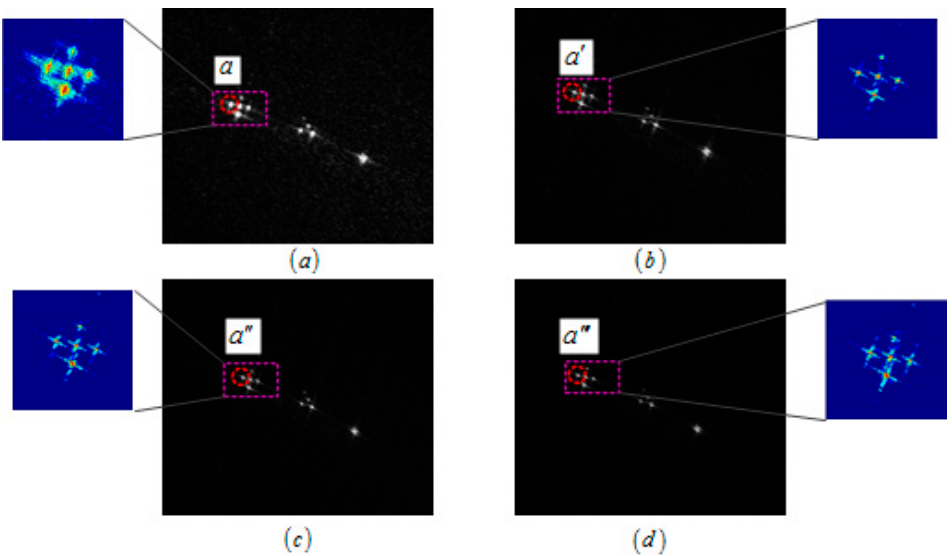
Remote Sens. 2021 , 13 , x FOR PEER REVIEW 18 of 25 Figure 17. The imaging result of a single frame. ( a ) Original image corrupted by azimuth-variant phase error. ( b ) Imaging result refocused by MD. ( c ) Imaging result refocused by MD and PGA. ( d ) Imaging result focused by PGA directly.